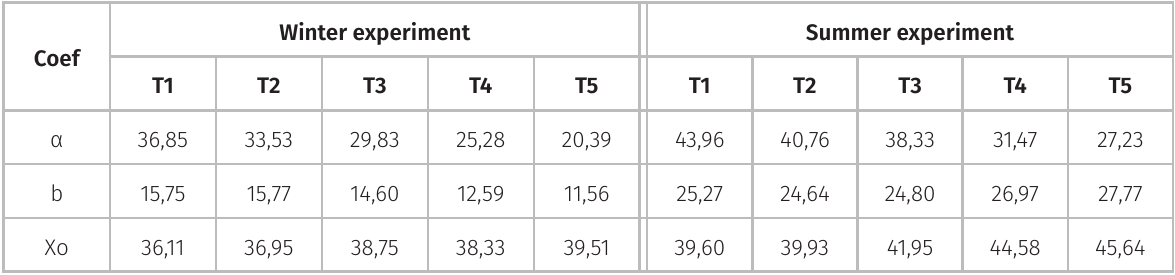
Table I. Parameters of the sigmoidal model, fitted to root growth data, for each of the treatments in the winter and summer experiments for soybean